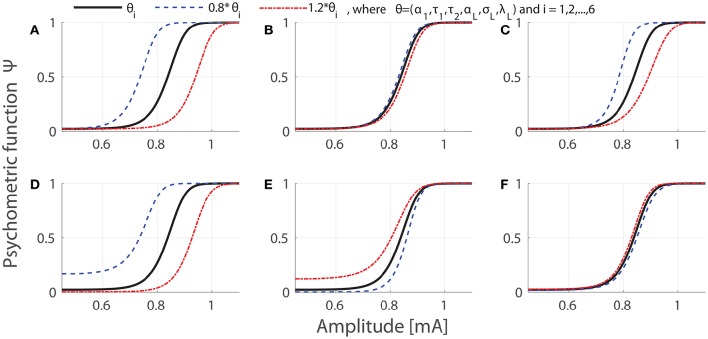
Effects of parameter variations on the psychometric curves. We set temporal properties of stimulation as NoP = 1 and PW = 0.42 ms. In each panel, psychometric curves evaluated at reference values, decreased or increased values of single parameters are shown in black, blue or red, respectively. The panel indices (A–F) correspond to indices 1–6 for single parameters, respectively.